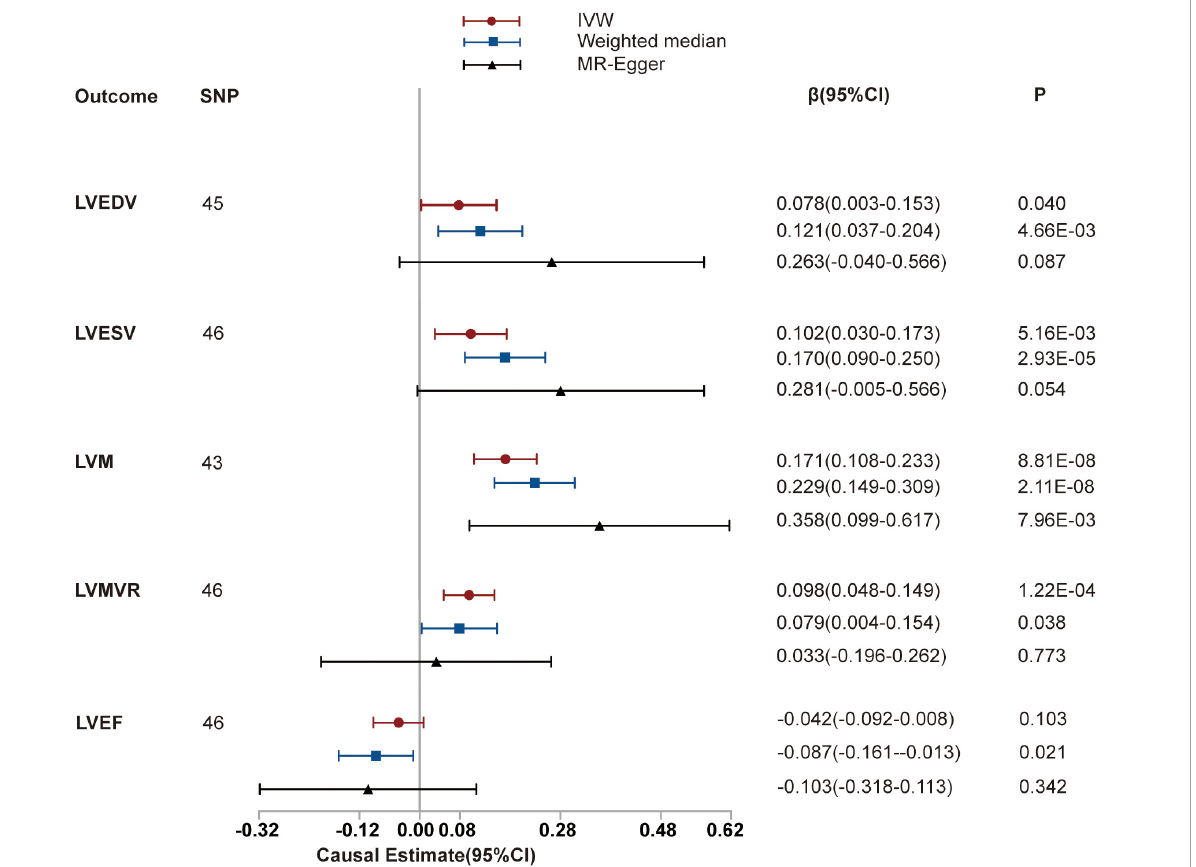
endothelial cells, fibroblasts and the immune system